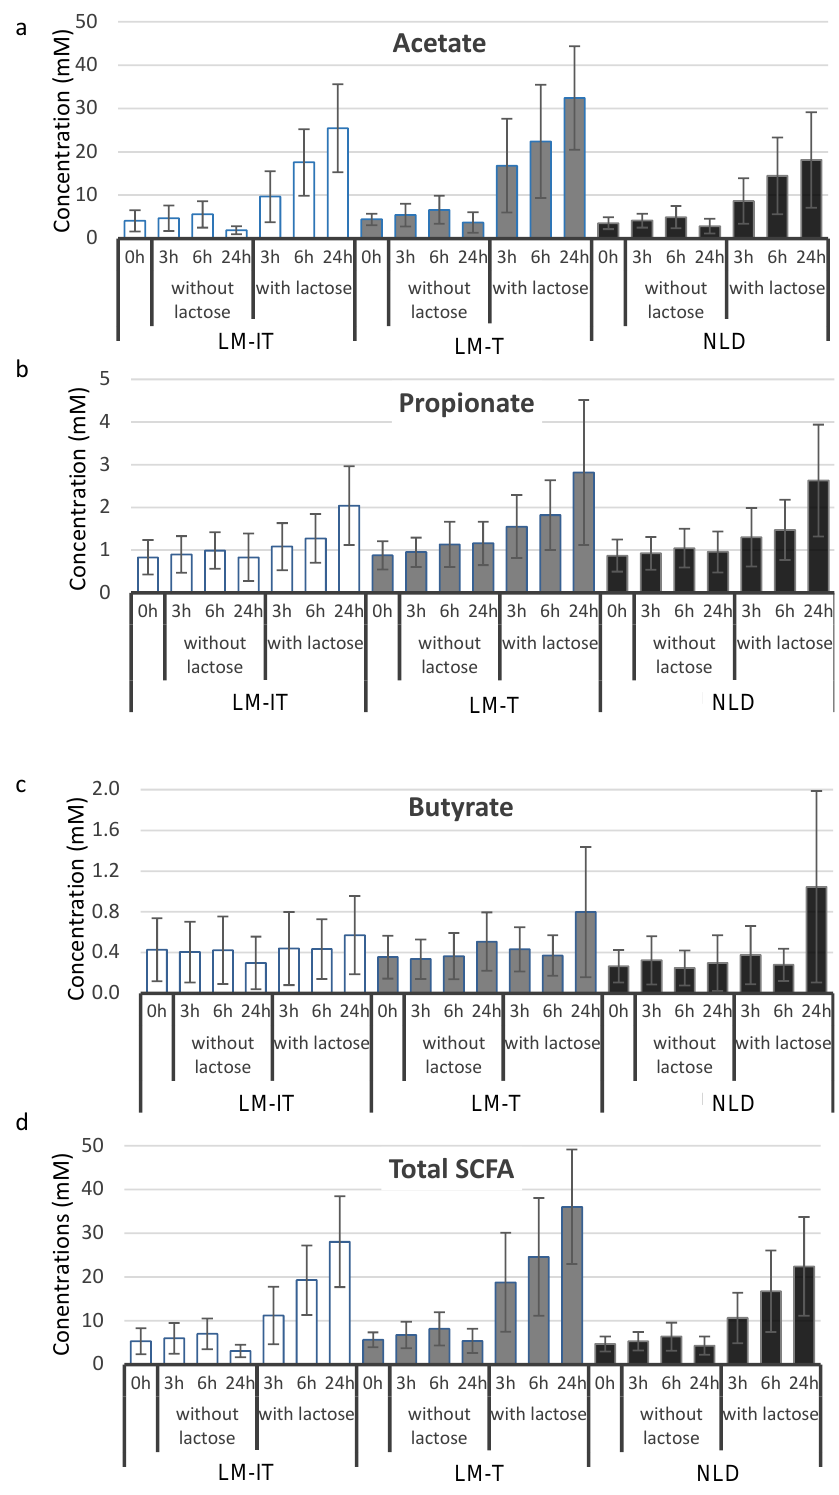
Figure 3. Mean concentrations of acetate ( a ), propionate ( b ), butyrate ( c ) and total SCFA ( d ) at baseline (0 h) and after incubation for 3 h, 6 h and 24 h with and without 6.25 mg of lactose in 1/40 diluted slurries from samples collected by subjects with LM-IT, LM-T or NLD. NLD: normal lactose digestion; LM-IT: lactose malabsorption with abdominal complaints; LM-T: lactose malabsorption with without abdominal complaints.